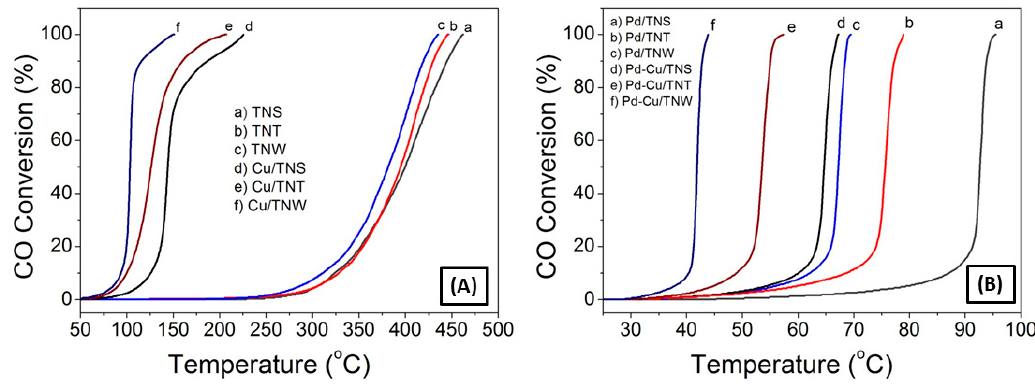
Figure 8. CO oxidation light-off curves of TNS, TNT and TNW support ( A ) before and after Cu loading to the support alone, ( B ) before and after adding Cu to Pd-TiO 2 support.